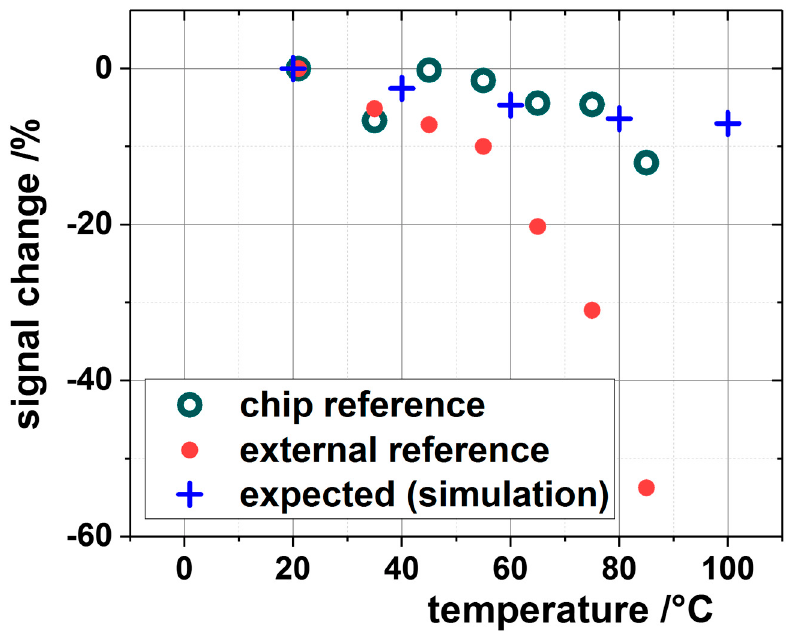
Figure 3. 3 ω Measurement of water from 20 °C to 80 °C with on-chip reference (green circles) and fixed external reference at 20 °C (red points). The expected values are marked as blue crosses and describes the influence of the temperature dependency of the specific thermal properties of water to the 3 ω -signal according to a COMSOL simulation. The uncompensated method shows strong deviations with higher temperatures (red